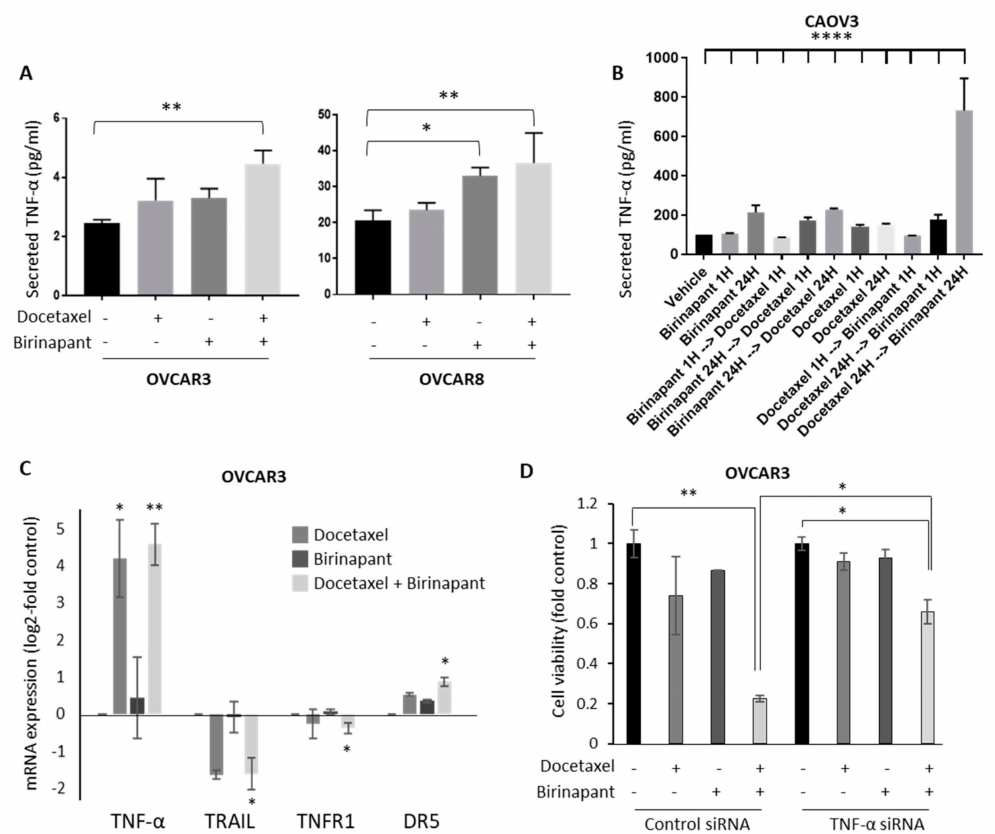
Figure 4. Docetaxel-induced TNF- α production in tumor cells is important for synergy with